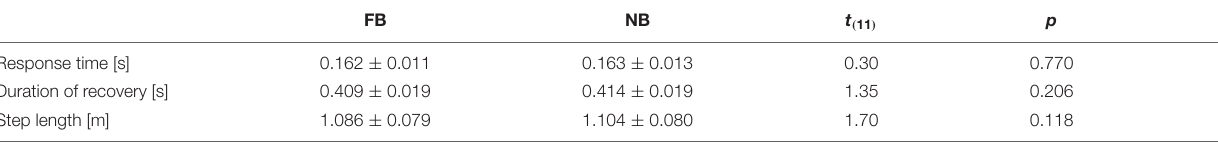
TABLE 1 | Spatiotemporal parameters for force-controlled biting (FB) and non-biting (NB). FB